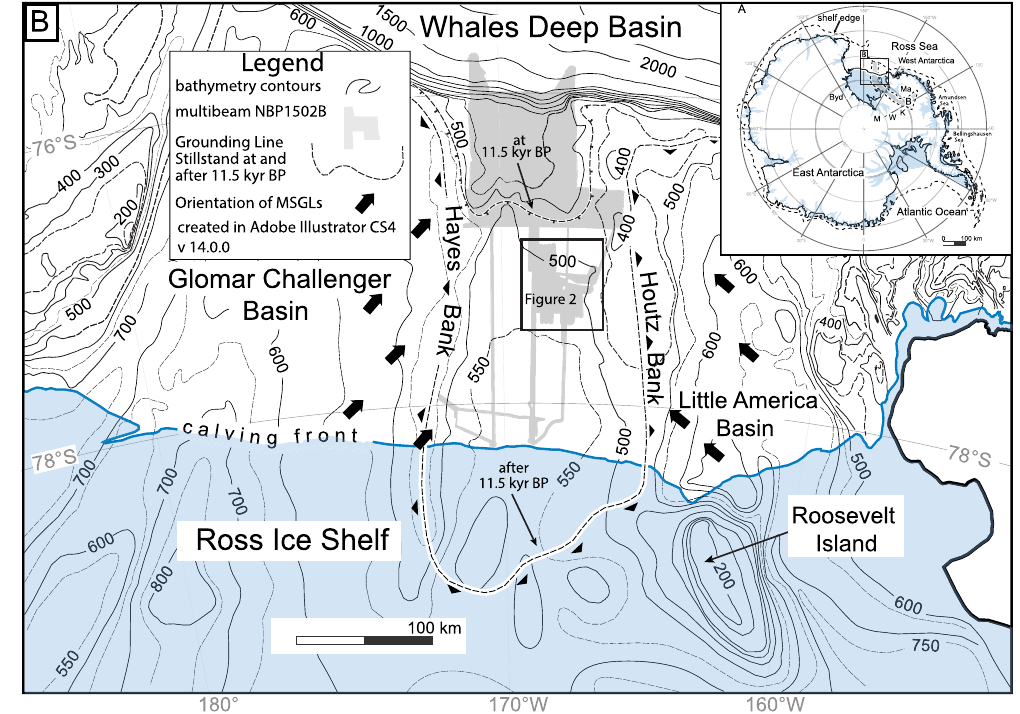
Figure 1. ( A ) Map of Antarctica showing the locations of the Whillans (W), Kamb (K), Bindschadler (B) and MacAyeal (M) ice streams. RIS = Ross Ice Shelf. GL = modern grounding line 6,8 . ( B ) Bathymetry contours from Davey and Nitsche 14 for eastern Ross Sea north of the Ross Ice Shelf calving front. The gray shade shows the location of multibeam and sonar data acquired during NBP1502B 16 . The dashed lines show the grounding line stillstand positions at and after 11.5 ± 0.3 cal kyr BP 8,18